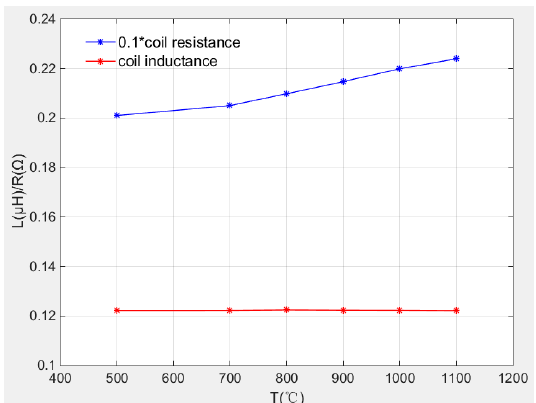
Figure 16. Comparison of L and R under different temperature.